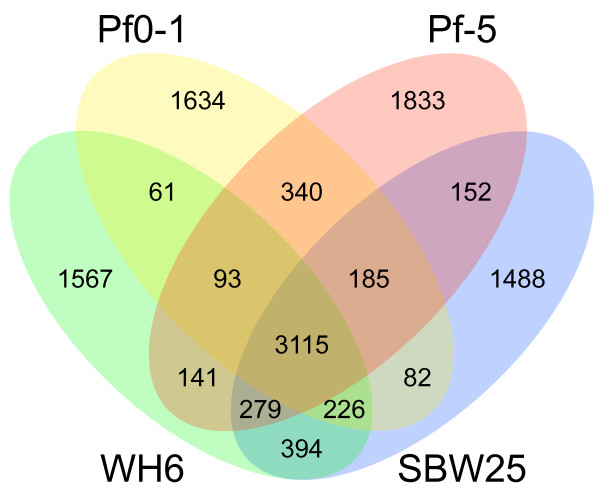
Venn diagram comparing the gene inventories of four isolates of P. fluorescens. The numbers of shared and unique genes are shown. Comparisons were made using HAL.